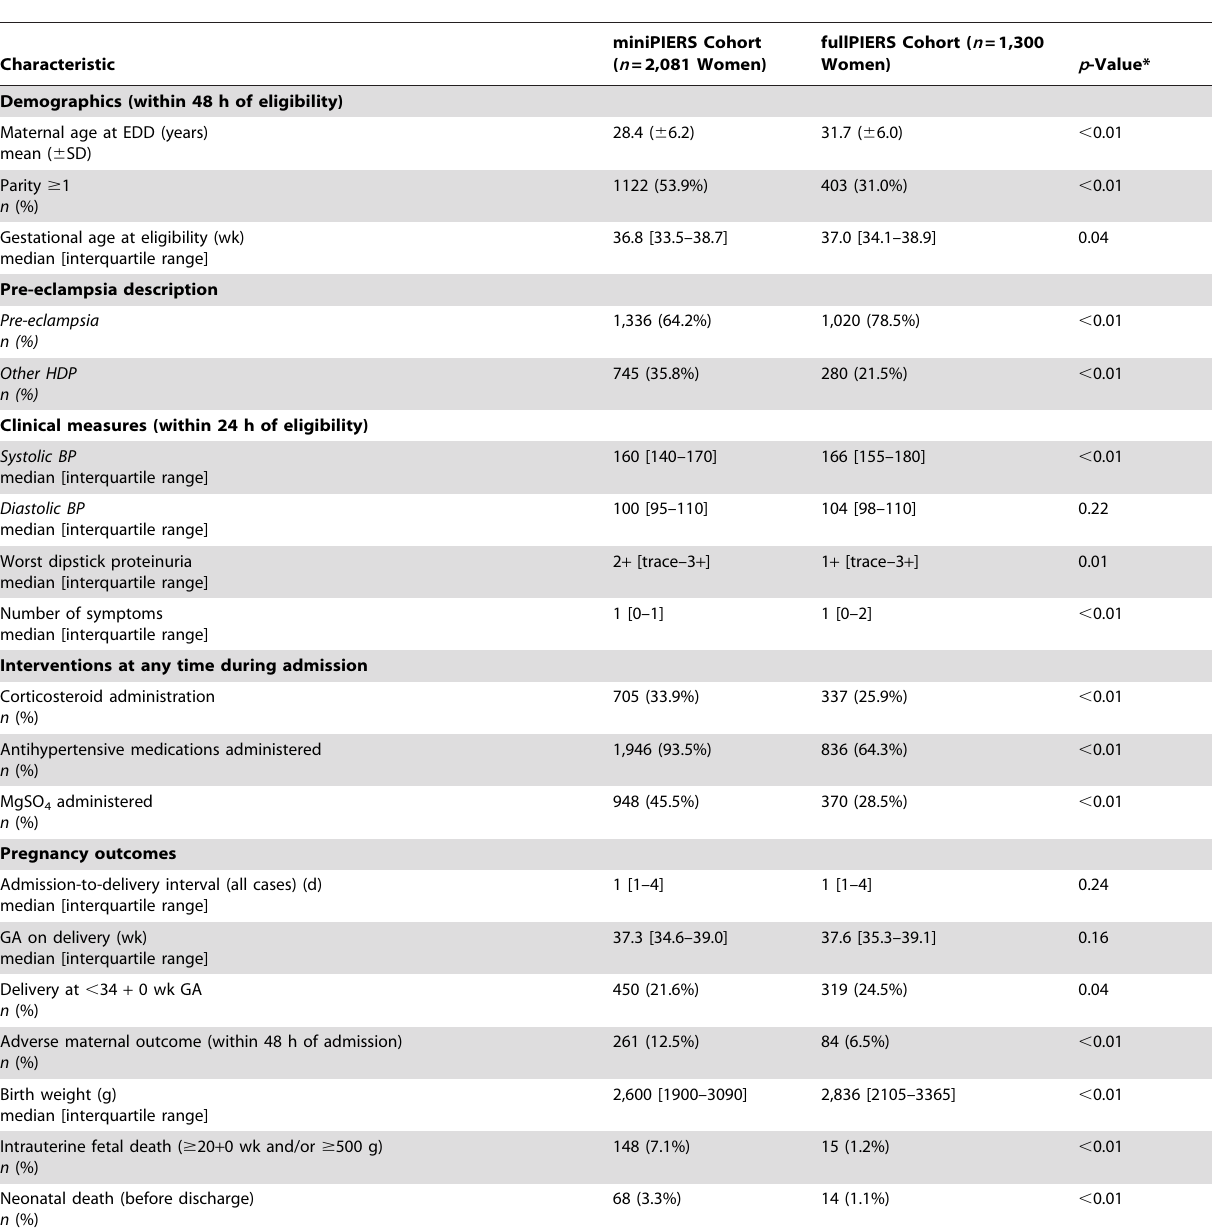
Table 5. Demographic table comparing characteristics of women in the development and validation